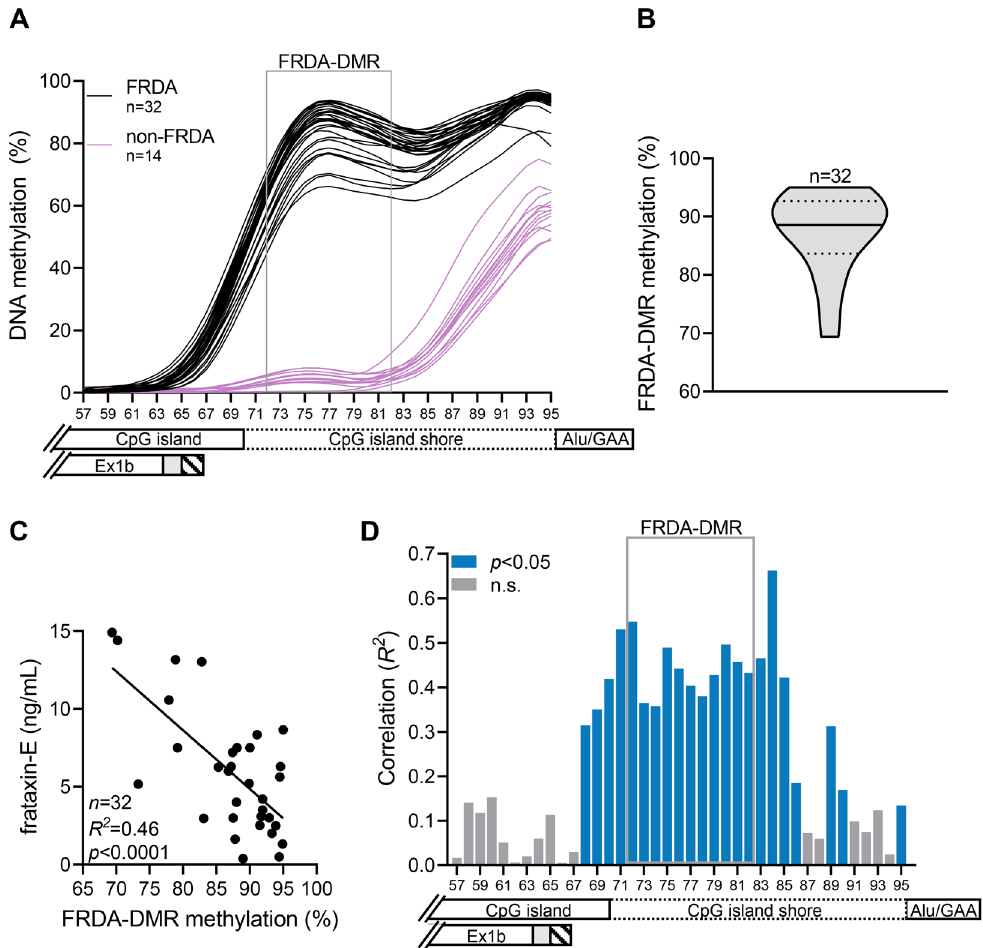
Figure 4. Deficiency of frataxin-E correlates with FXN DNA hypermethylation in FRDA. ( A ) DNA methylation is plotted as a percentage of 1000 sequencing reads, at each of 39 CpG dinucleotides (numbered 57–95) that map between the 3 ′ end of the CpG island and the Alu repeat element that contains the expanded GAA repeat. The data are displayed as LOWESS trendlines for FRDA (n = 32; black lines) and non-FRDA controls (n = 14; purple lines). The FRDA-DMR is outlined with a gray box, and the relative locations of the CpG island, CpG island shore, Alu/GAA, and Ex1b are indicated. ( B ) FRDA-DMR hypermethylation among the FRDA patients in our cohort (n = 32); the solid and dotted lines within the violin plot indicate median and 25th/75th percentiles, respectively. ( C ) Frataxin-E protein is inversely correlated with FRDA-DMR methylation. ( D ) Bar graph showing R 2 values (Pearson) for correlation of frataxin-E levels in the 32 patients with methylation at each of the 39 CpG sites. Note the clustering of CpG sites showing significant correlation (blue bars; with Benjamini and Hochberg correction for multiple comparisons) in the FRDA-DMR (gray box). Gray bars indicate correlations that are not significant (n.s.). The relative locations of the CpG island, CpG island shore, Alu/GAA, and Ex1b are displayed below the